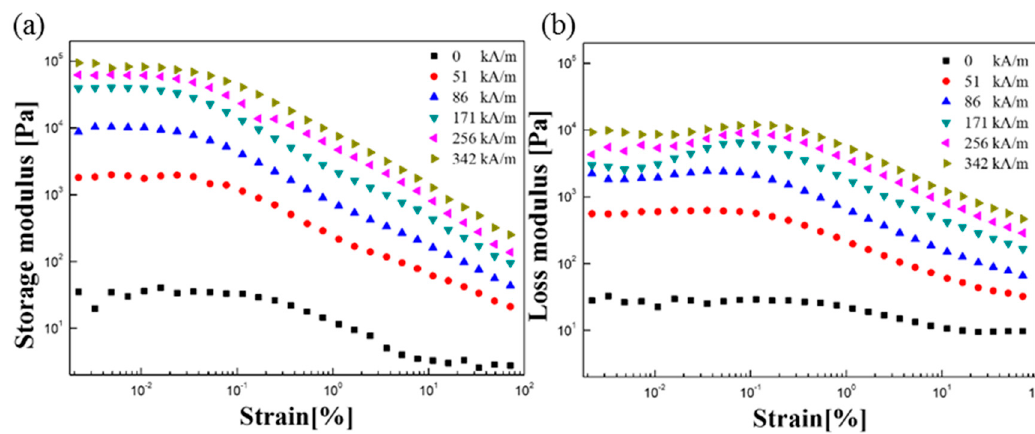
Figure 9. Amplitude sweep dependence of ( a ) storage modulus (G’) and ( b ) loss modulus (G’’) for Fe 3 O 4 /POA-based MR suspension.